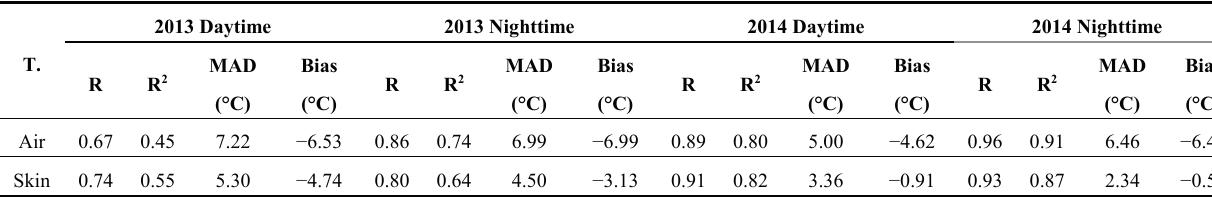
Table 4 . R and R 2 correlation coefficient values, MAD, and biases between VIIRS LST daytime and nighttime views for the forest/vegetation covered pixel and T-skin and T-air at CREST-SAFE for winters 2013 and 2014.